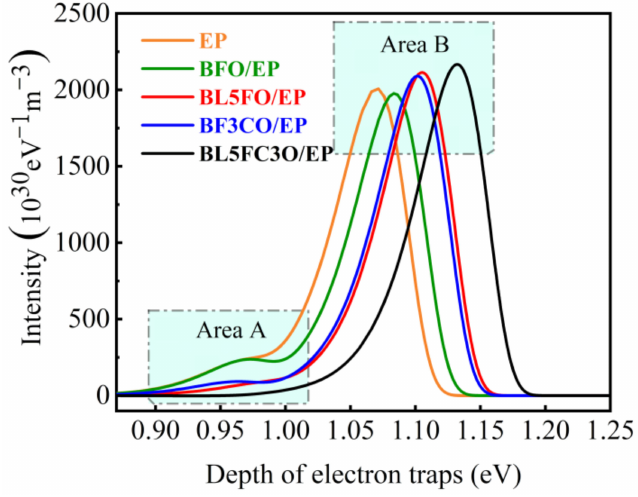
Figure 10. The characteristic curve of trap energy level distribution of EP composite with nano-filler doping (filling concentration of 4